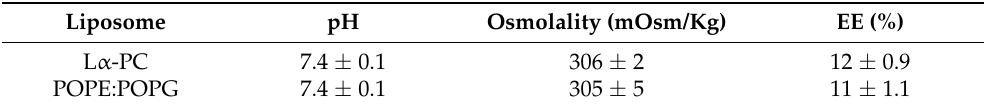
Table 4. pH, osmolality, and encapsulation efficiency (EE) of the liposomes. Results are expressed by mean ± SD (n = 3). Liposome pH Osmolality (mOsm/Kg) EE (%) L α